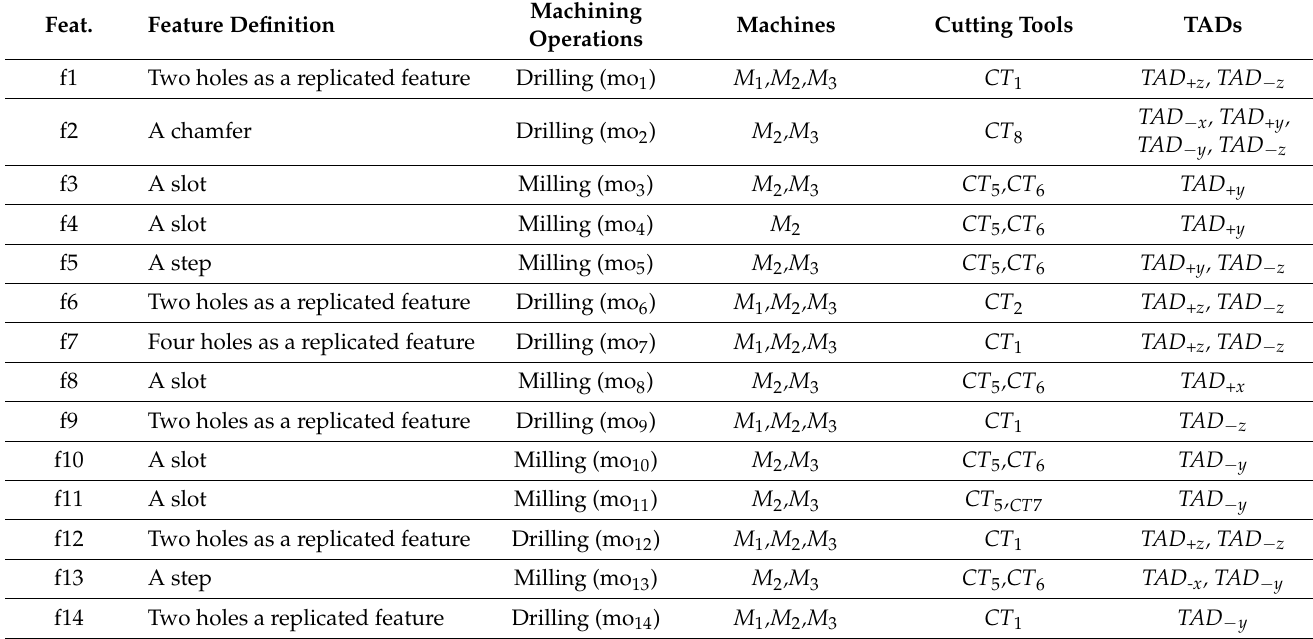
Table 3. Information about features and resource candidates for prismatic part 2.